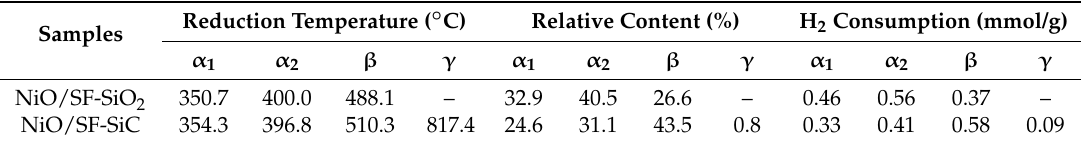
Figure 5. H 2 ‐ TPR profiles of the as ‐ prepared NiO/SF ‐ SiO 2 and NiO/SF ‐ SiC catalysts. Table 3. Gaussian fitting analysis of H 2 temperature programmed reduction (H 2 -TPR) patterns of different catalysts.